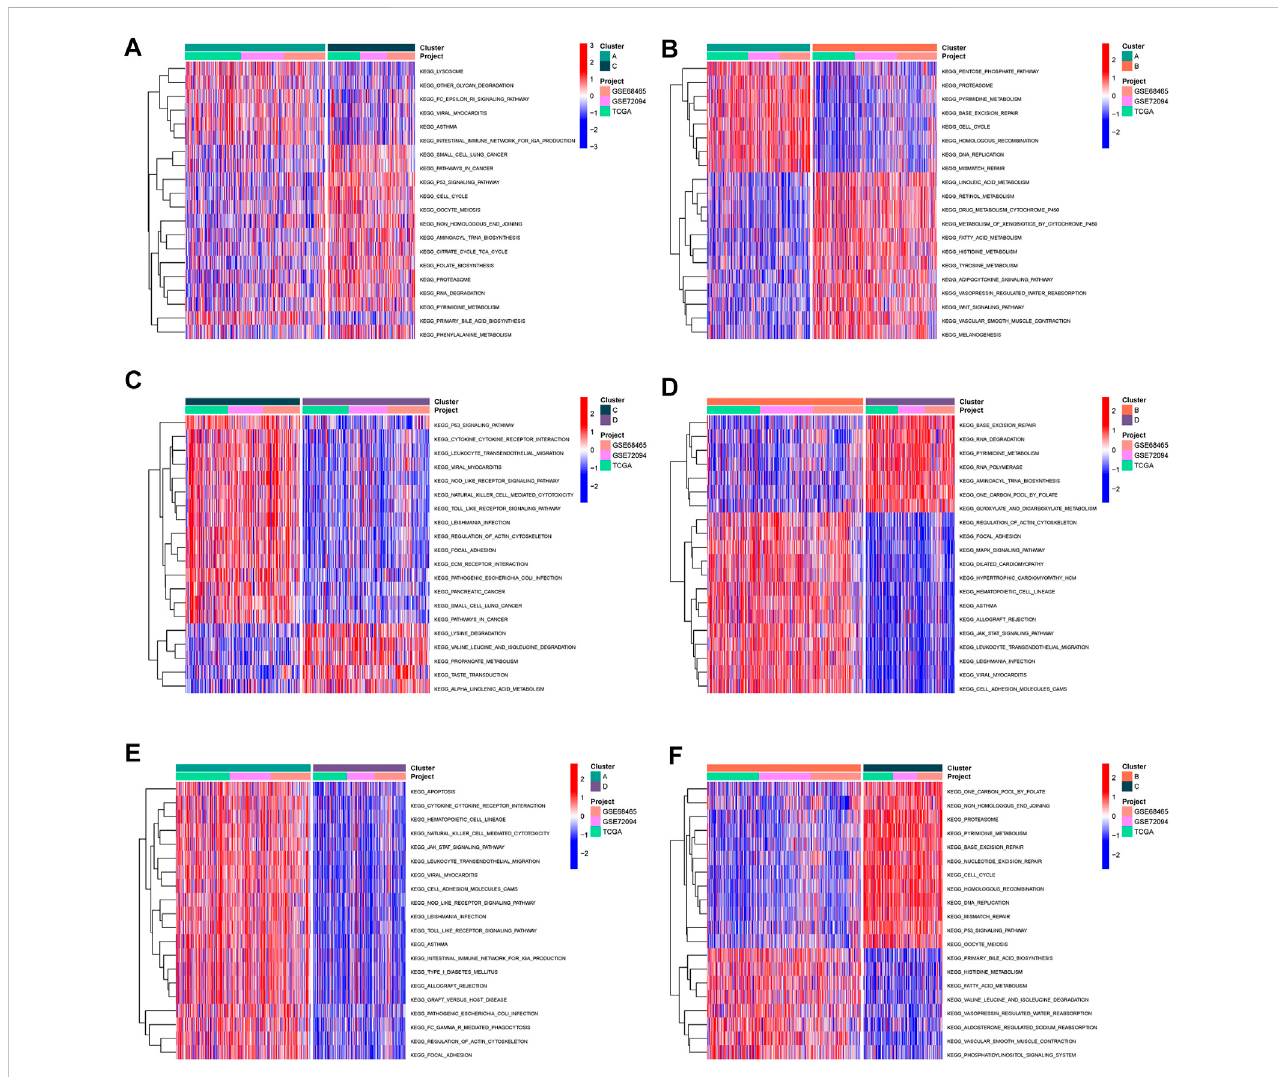
FIGURE 4 Pathway enrichment analysis (A – F) The heatmap displayed the biological processes among each cluster, plotted by GSVA